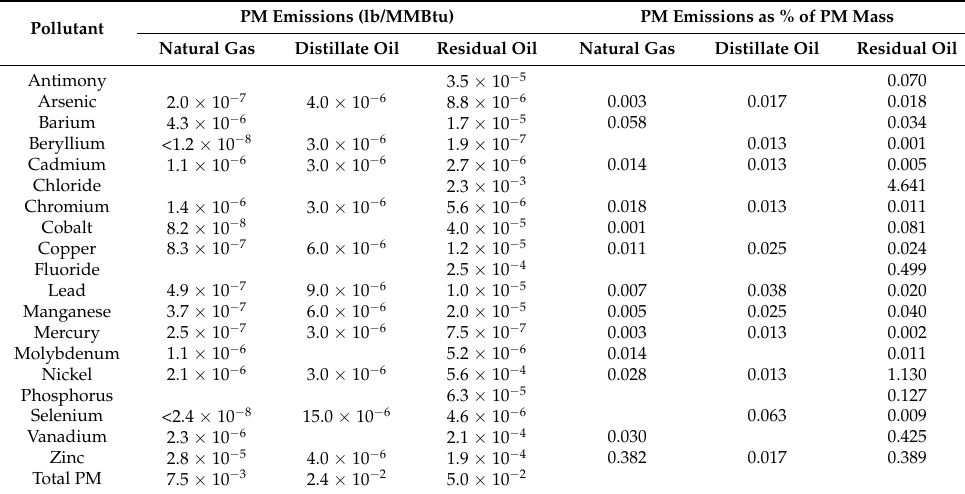
Table 1. Metals content of fossil fuel combustion particulate matter emissions [28].